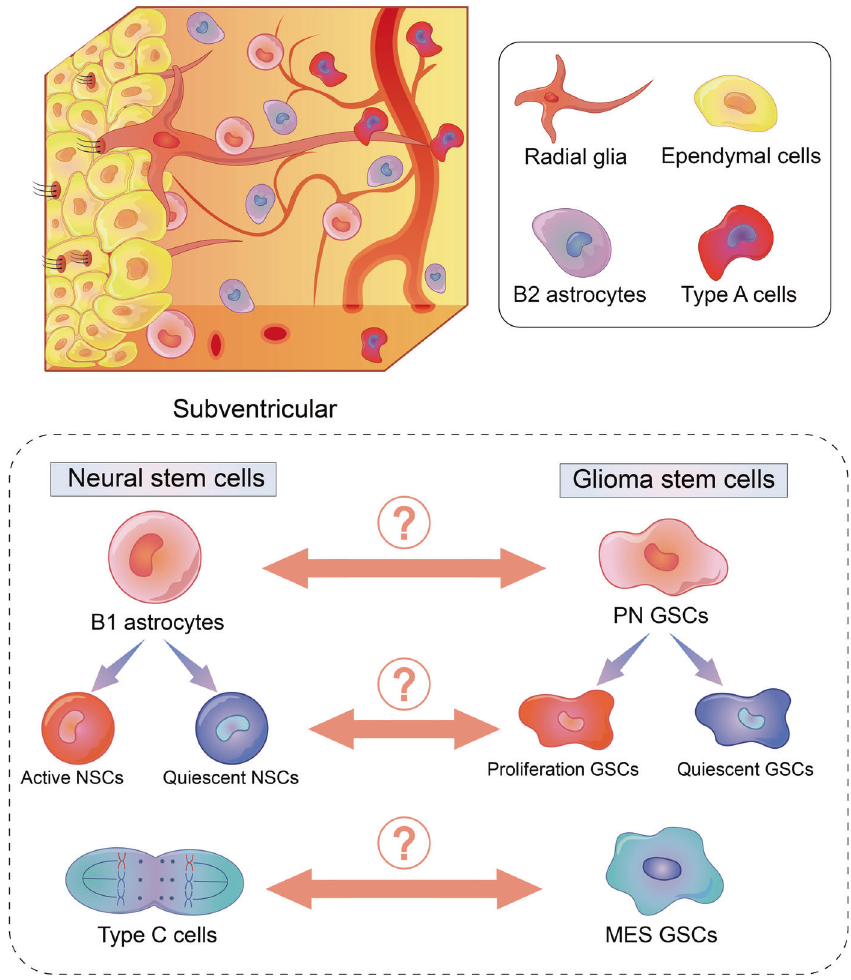
Fig. 4 Association between subventricular NSCs and GSCs. Similarities, including genomic characteristics and metabolism pattern, are found between PN GSCs and B1 astrocytes, MES GSCs and type C cells. The biological behavior of B1 astrocytes is similar to GSCs. However, the explicit relationship between NSCs and GSCs remains